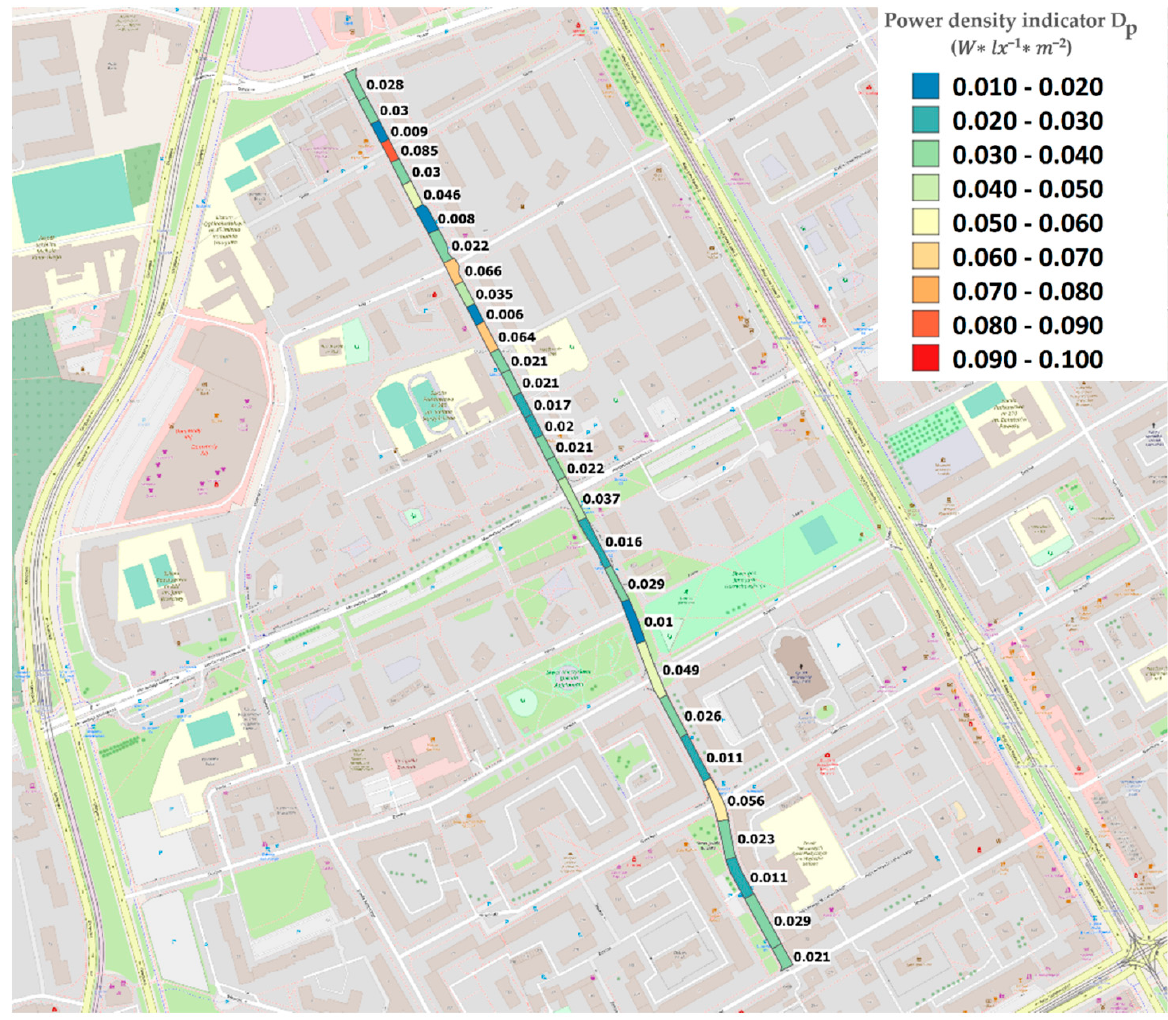
Figure 14. Power density indicator D P (W ∗ lx − 1 ∗ m − 2 ) of calculated fields on the map.